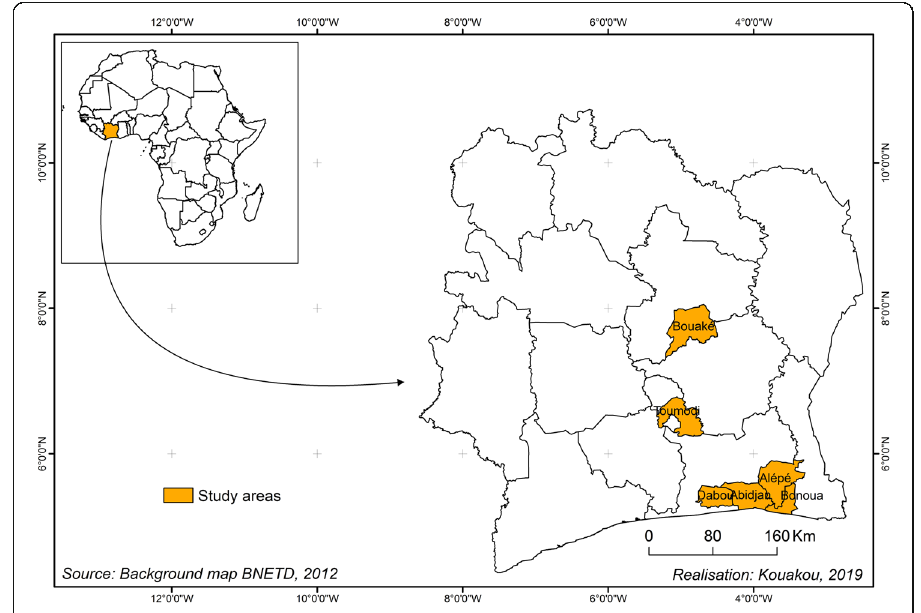
Fig. 1 Location of the study areas in Côte d ’